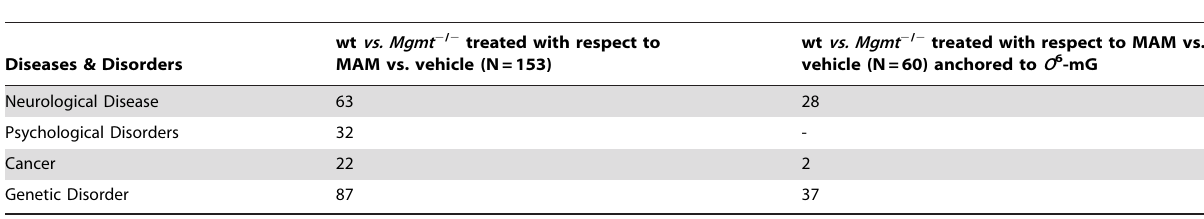
Table 2. Top MAM-sensitive biological functions in wt and Mgmt 2 / 2 mouse brains.